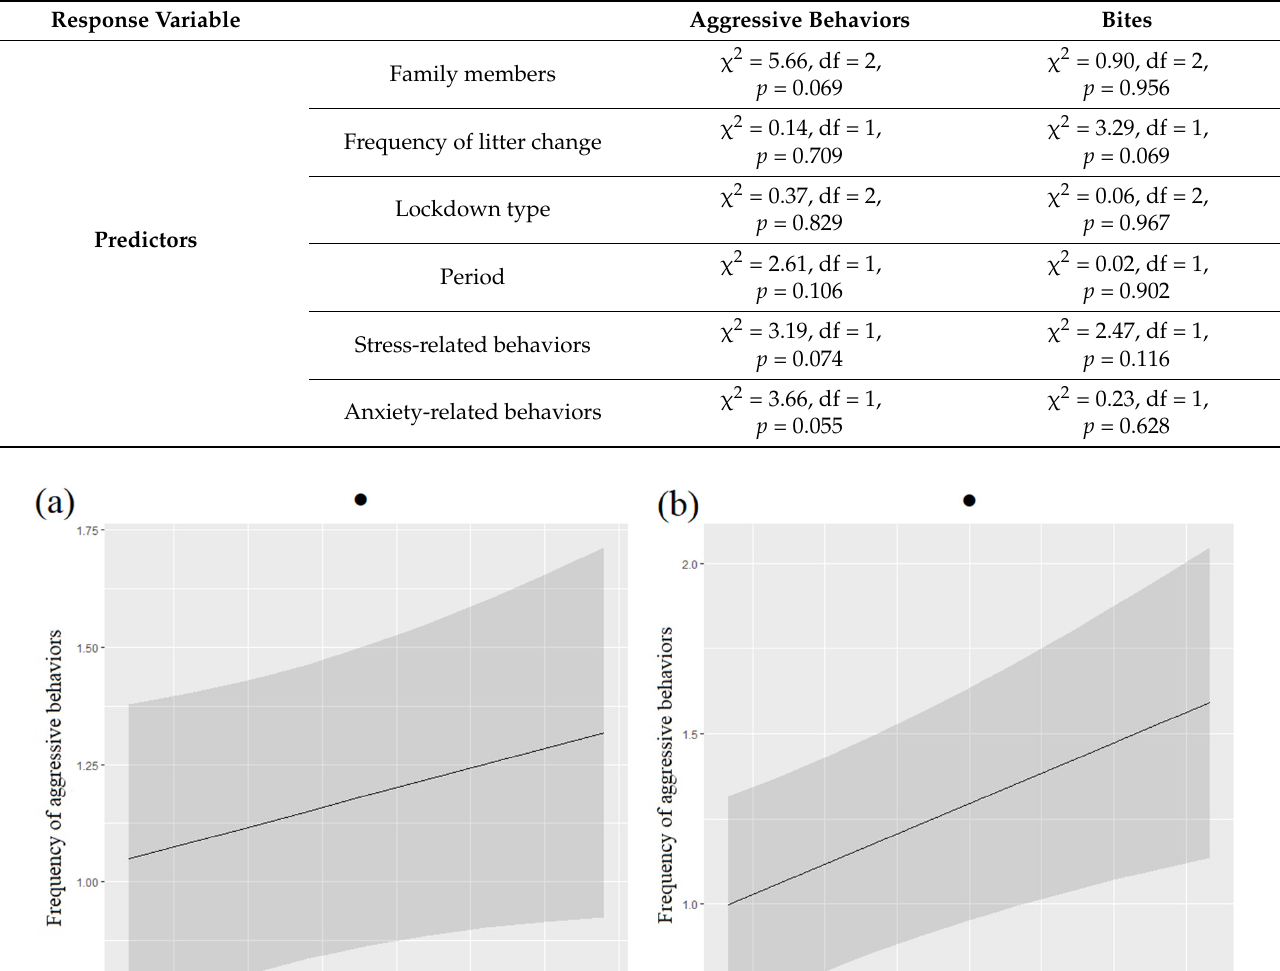
Table 6. Statistical outputs from ordinal logistic regressions for cats.